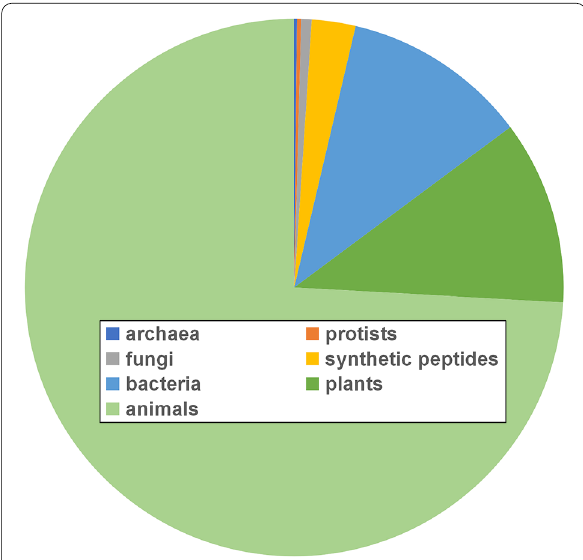
Fig. 1 Sources of antimicrobial peptides from the antimicrobial peptide database (http:// aps. unmc. edu/